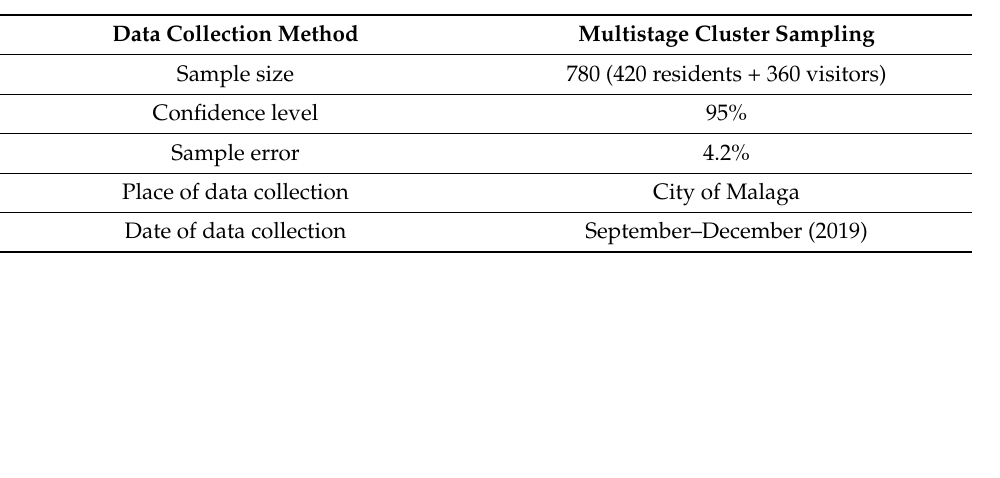
Table 1. Data collection